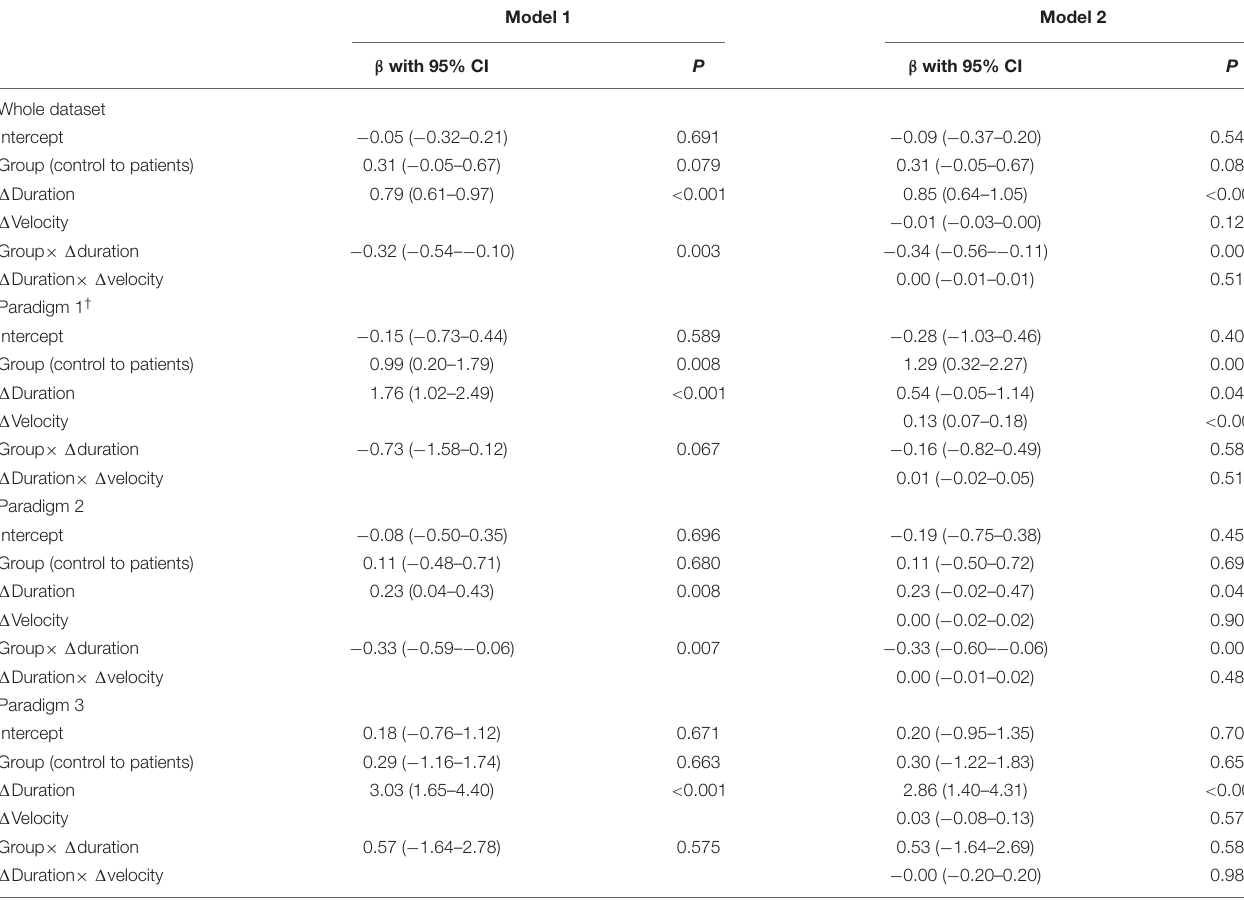
TABLE 2 | Statistical analyses for duration